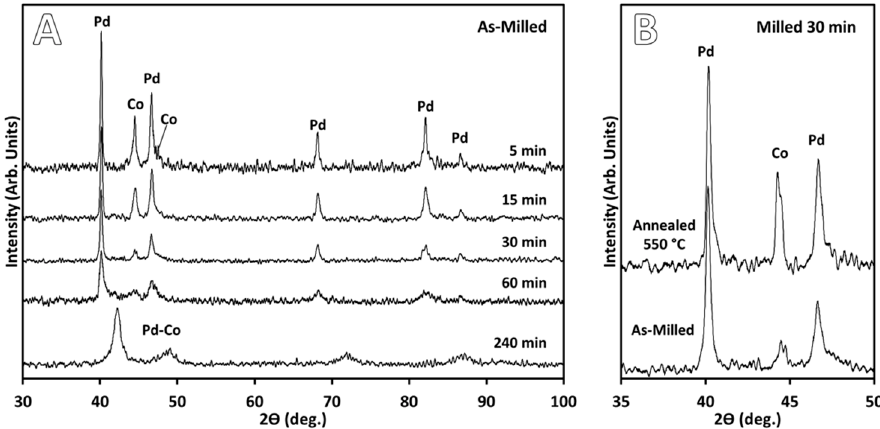
Figure 1. XRD profiles for samples ( A ) produced using milling times listed, and ( B ) samples milled for 30 min in the as-milled condition and after annealing at 550 °C for 1 h.